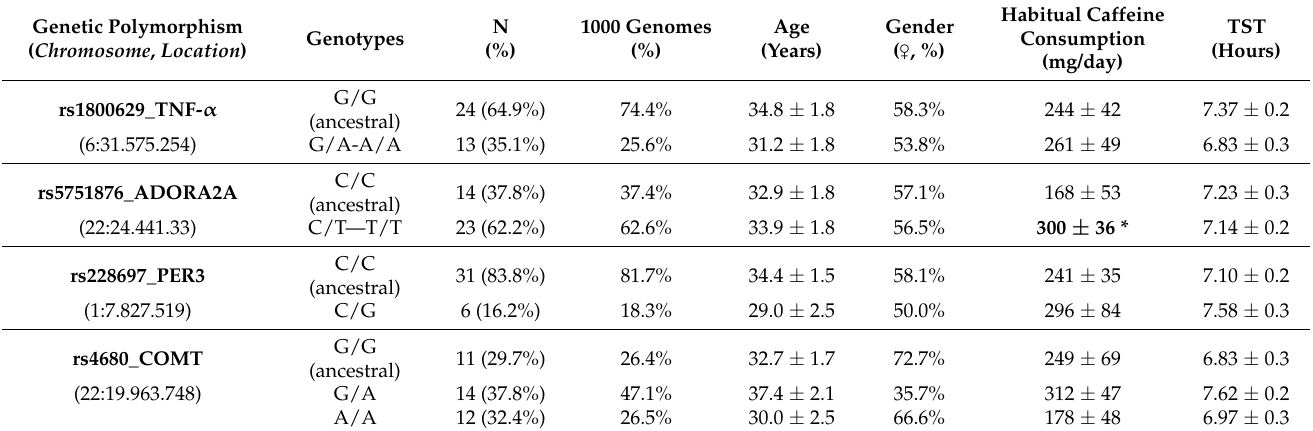
Table 1. Genetic polymorphisms distribution and individual characteristics in the studied population compared to 1000 Genomes international database, an expected based on 1000 Genomes Project data on the GRCh38 reference assembly (http://www.internationalgenome.org, latest access on 04/09/2020). Genetic Polymorphism ( Chromosome , Location )